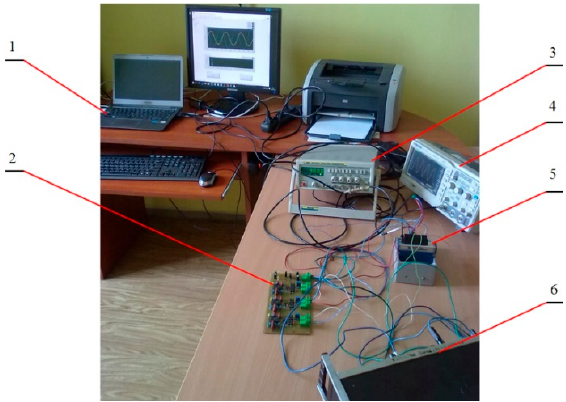
Figure 2. The stand for testing the analog filters used in the lines for measuring the electrical quantities of a roadheader cutterhead’s drive.